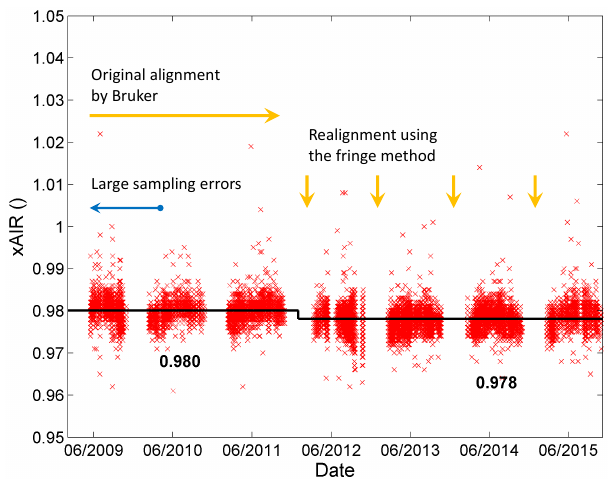
Figure 3. Time series of xAIR. Average xAIR values are shown